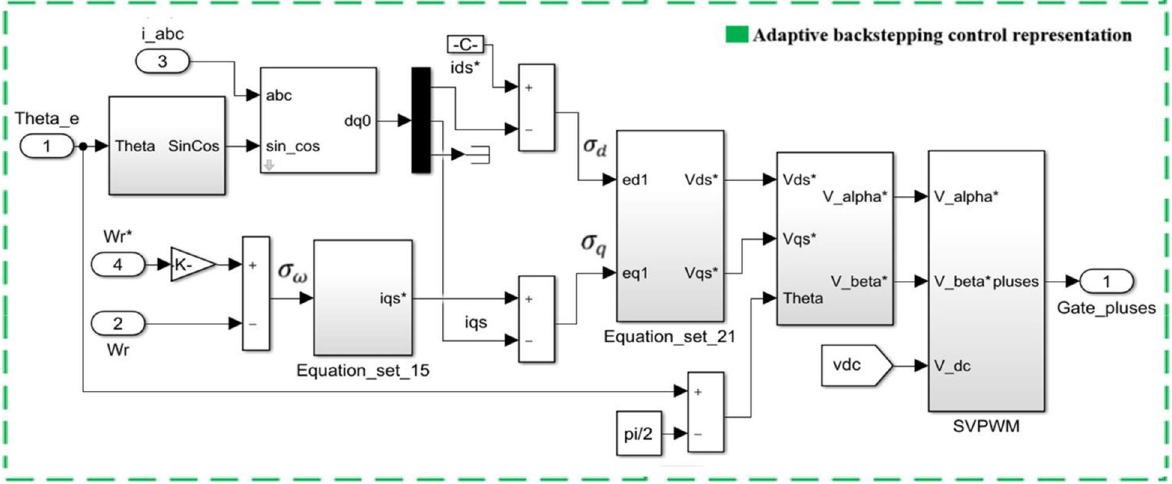
Fig. 5 Adaptive control strategy in Matlab/Simulink